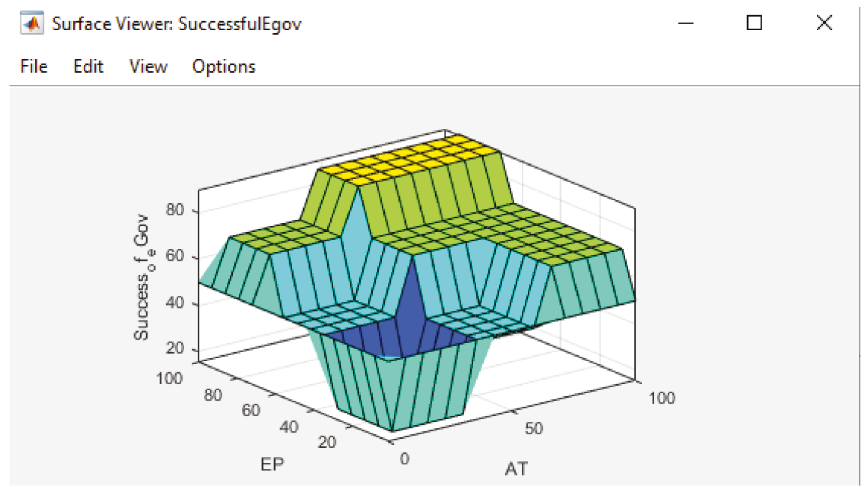
Figure 8: Three dimension of the EP and IAT with the success of e-government.